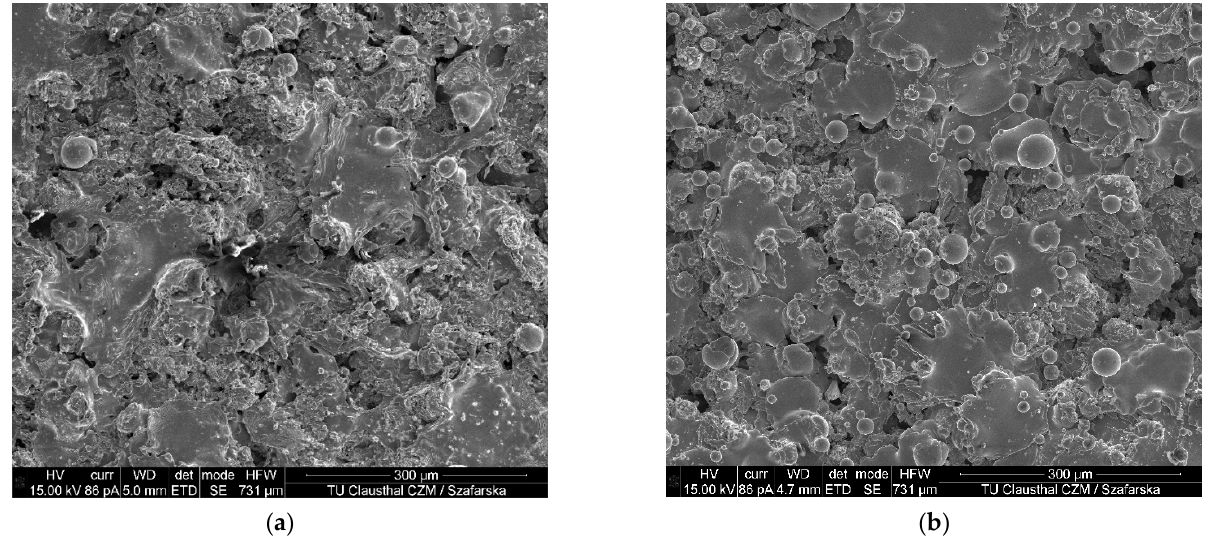
Figure 13. SEM images of the copper coating surfaces: ( a ) copper coating formed in air and ( b ) formed in silane-doped nitrogen.